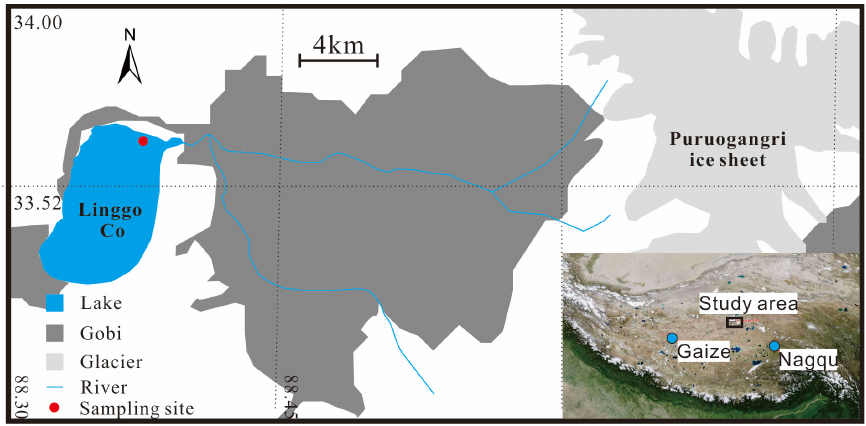
Figure 1. Location of the study area and the landscape of the catchment.